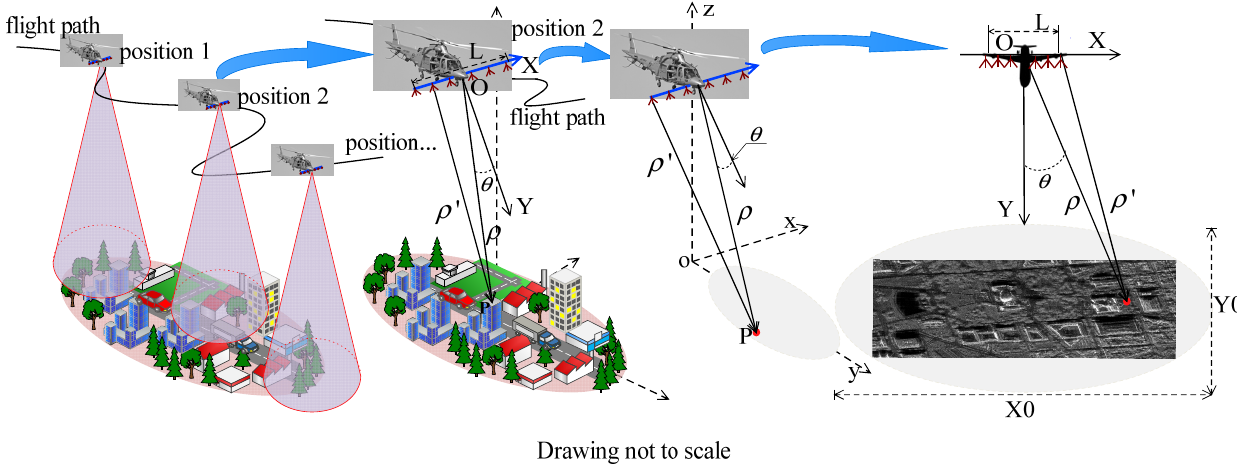
Figure 1. Autonomous navigation airborne forward looking SAR imaging